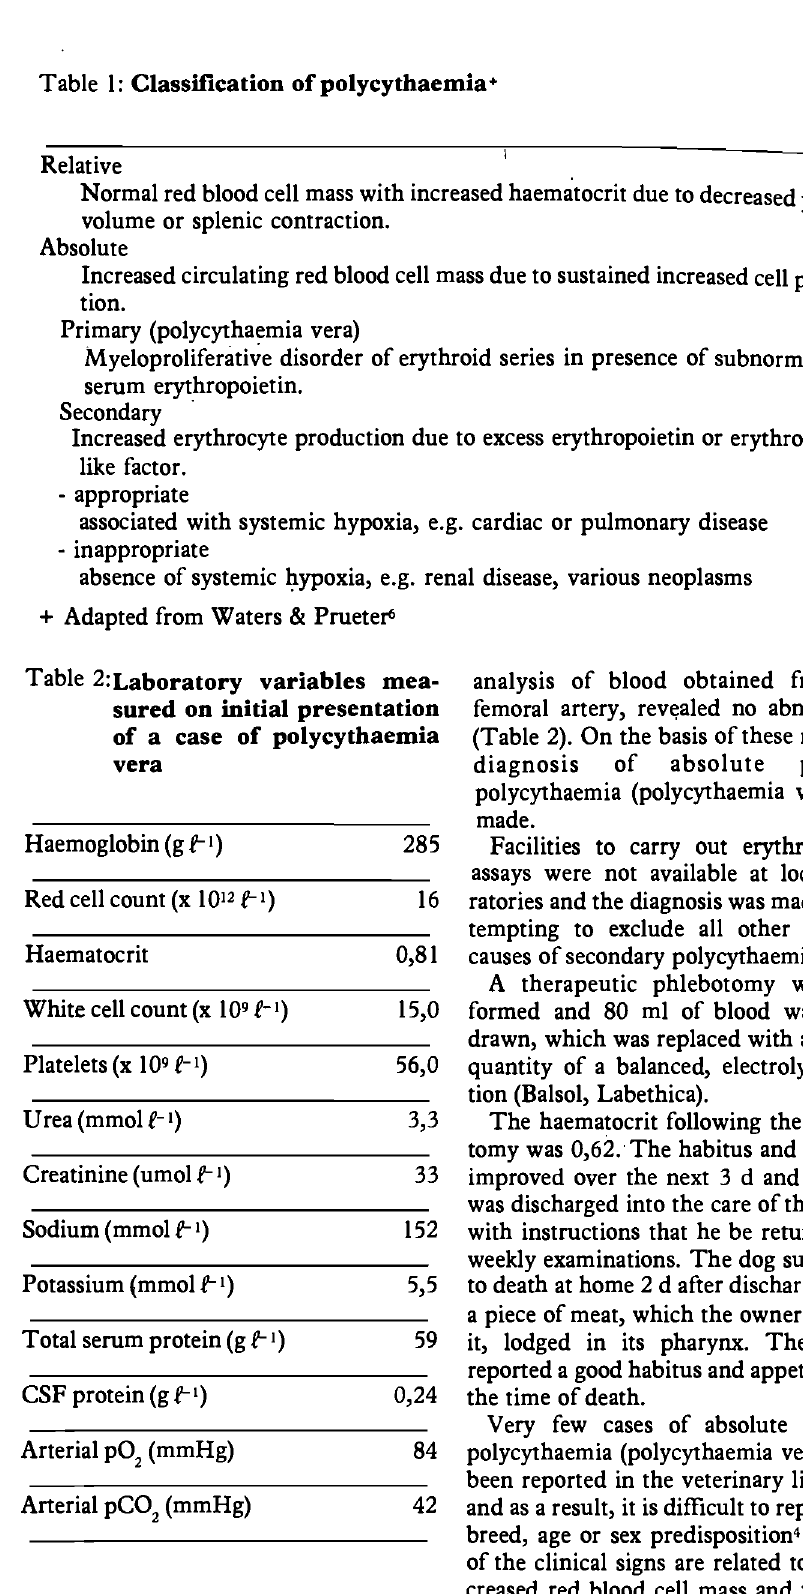
~~~ . Normal red blood cell mass with increased haematocrit due to decreased plasma volume or splenic contraction.